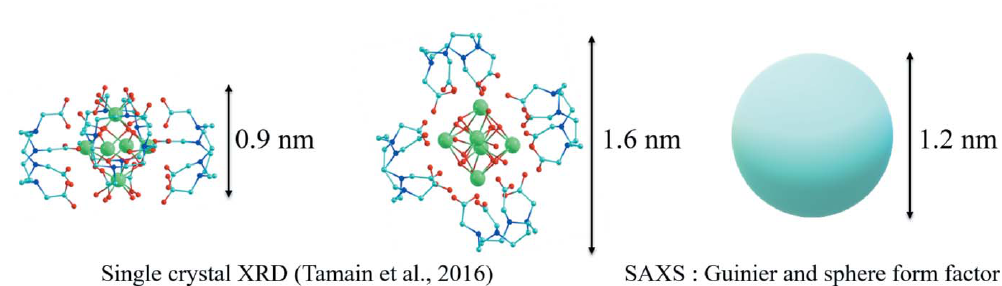
Figure 4 Comparison of the SAXS Guinier and sphere form factor models with the [Pu 6 (OH) 4 O 4 (H 2 O) 8 (HDOTA) 4 ] complex structure from single-crystal XRD (Tamain et al. , 2016). The complex structure, in the solid state, shows the anisotropic DOTA complexation on the octahedral [Pu 6 (OH) 4 O 4 ] 12+ core which results in an oblate